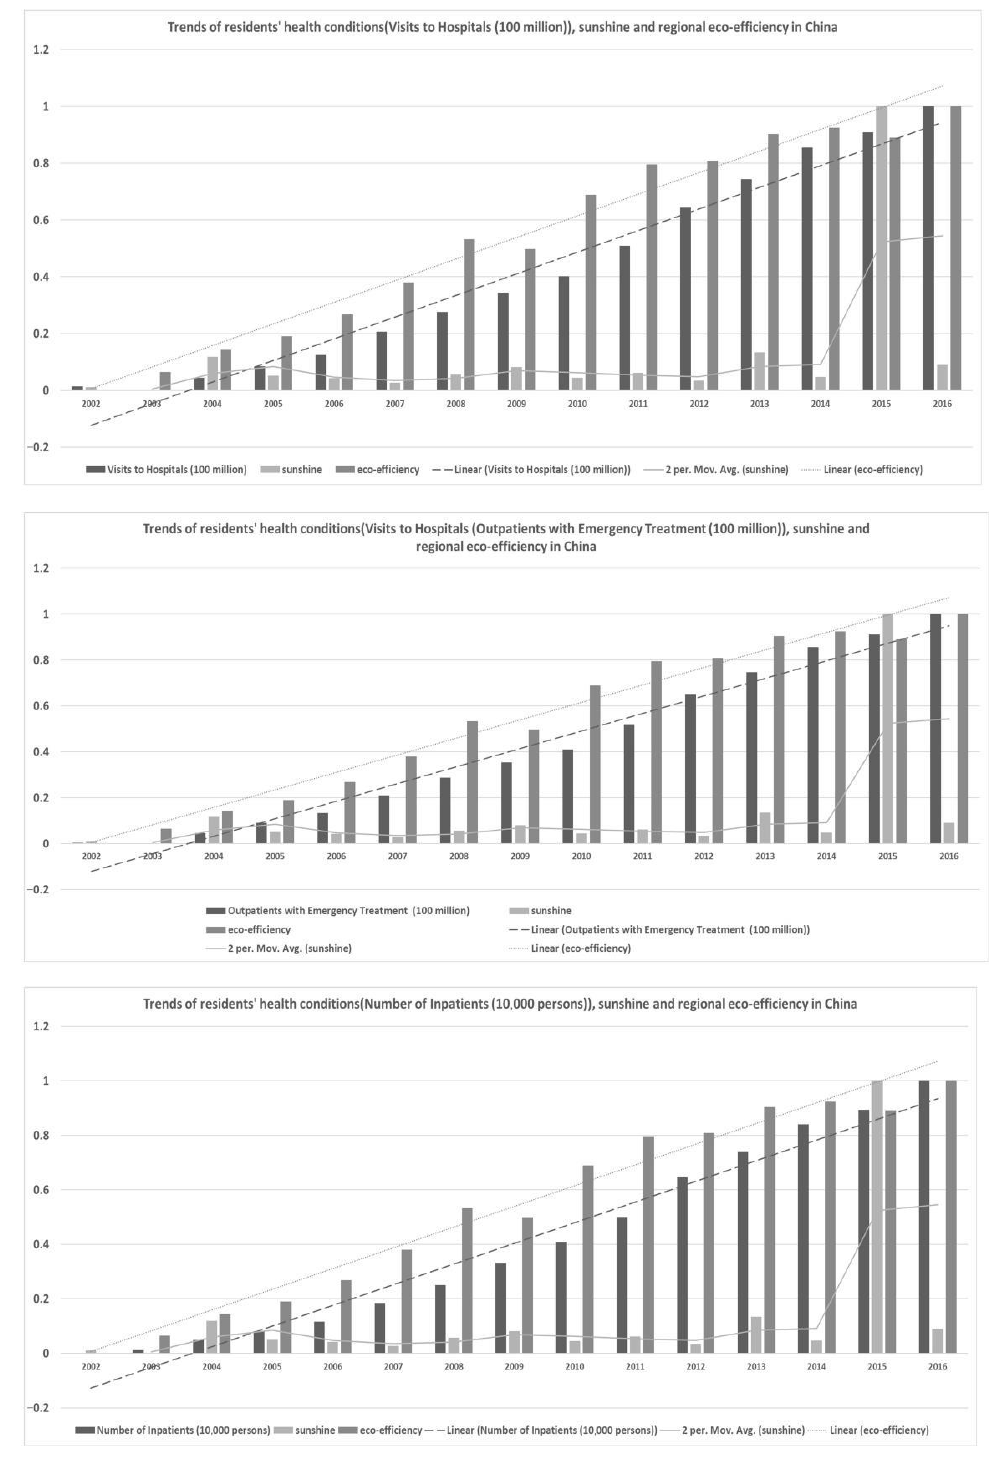
Figure 5. Trends of RHC , sunshine, and REE in China.